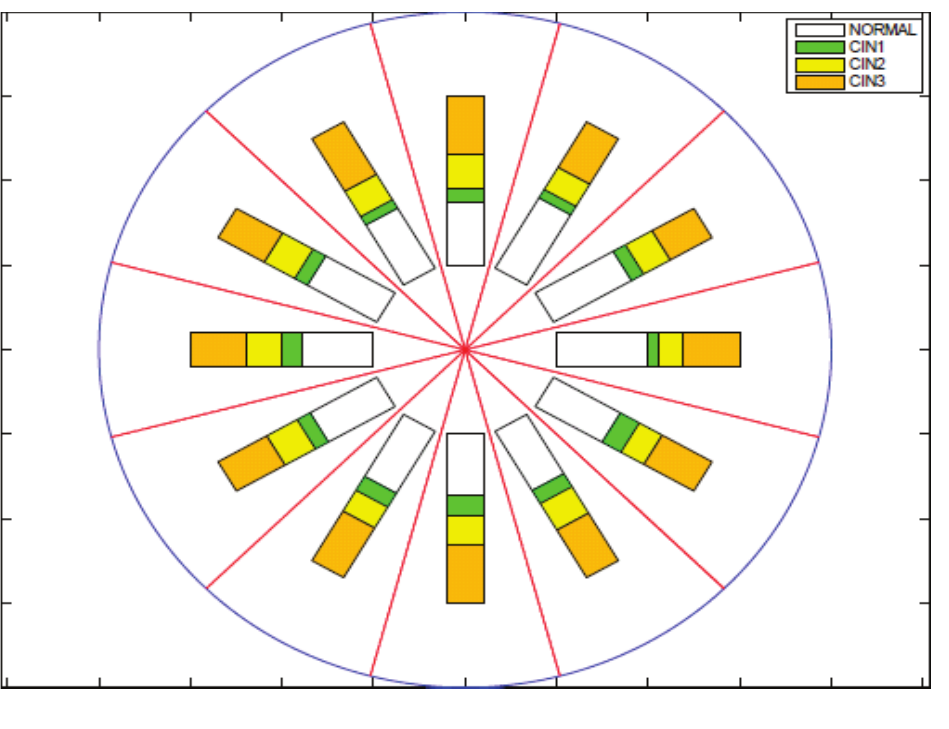
Figure 3. Distribution of CIN LEEP segments among women in SUCCEED diagnosed as CIN3 by LEEP (N=309).